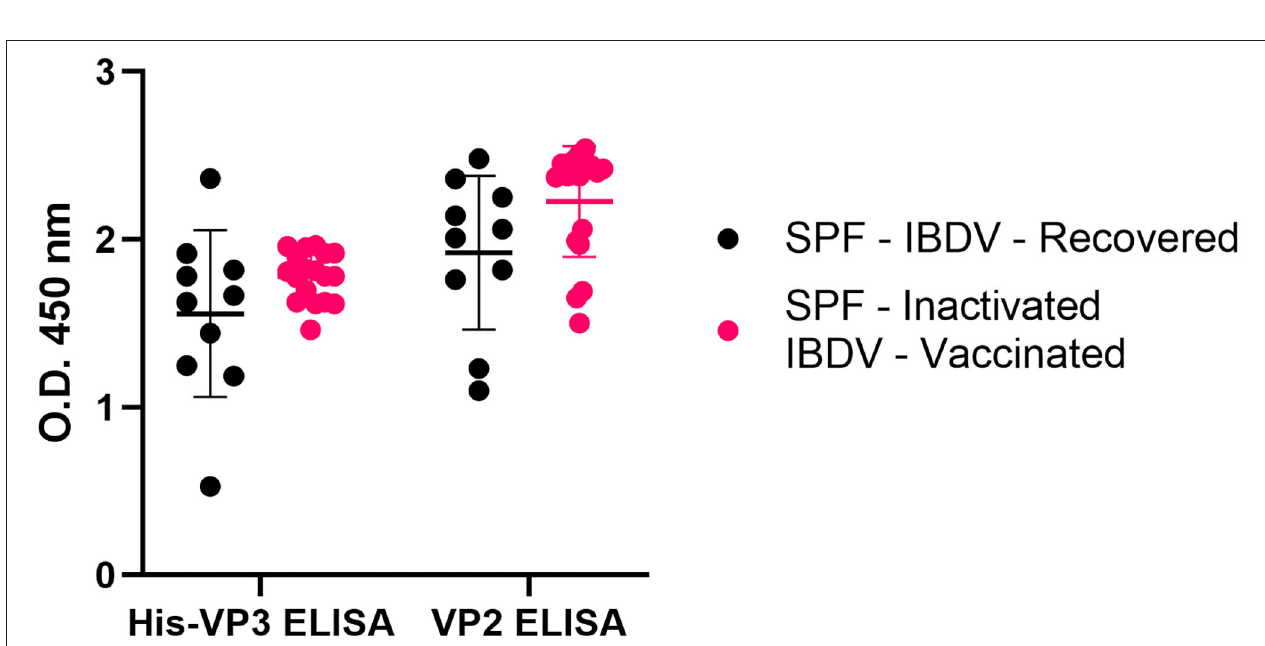
FIGURE 5 | Anti-VP2 antibodies in the sera of vaccinated SPF chickens do not interfere in the His-VP3-based ELISA. Distribution of O.D. 450 values of pre-challenge SPF chickens sera collected at different time points (SPF-VP2-VLP vaccinated, black; SPF-HVT-ND-IBD vaccinated, pink; SPF-Naïve, green) analyzed with (A) His-VP3 or (B) ID Screen® IBD VP2 ELISA. Horizontal and vertical bars: mean ± standard deviation (SD). The positive threshold for His-VP3 ELISA is indicated with a dotted line (O.D. 450 = 0.250).